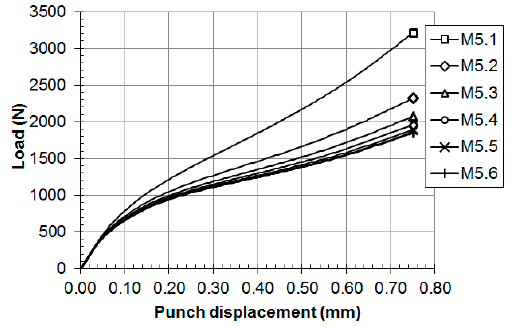
Figure 9. SPT curves for the hypothetical materials: M5.x.